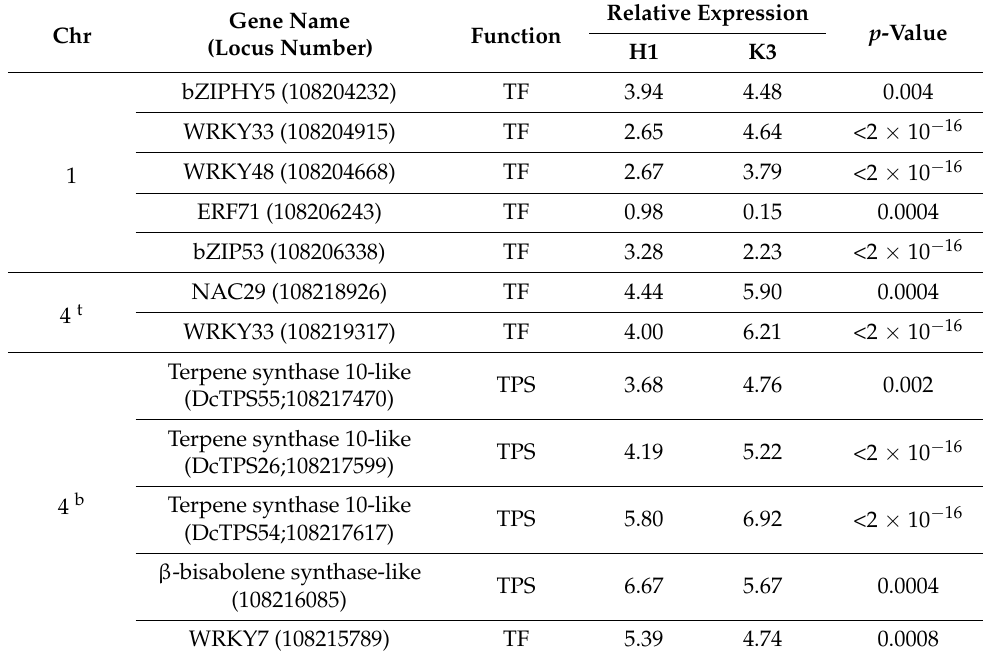
Table 3. Terpene synthase and transcription factor genes underlying co-localization regions, which are differentially expressed between H1 (susceptible) and K3 (resistant) genotypes. TF = transcription factor; TPS = terpene synthase; t and b = top and bottom of chromosome (Chr), respectively. Dc refers to TPS naming system proposed by